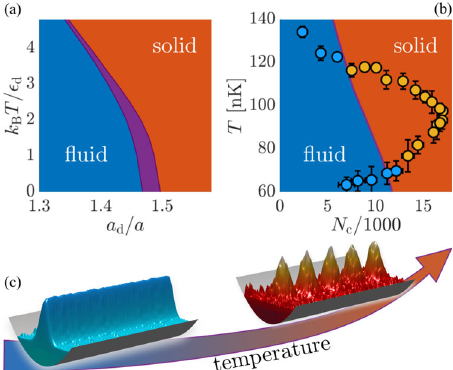
Fig. 1 | Temperature-driven formation of supersolidity. Heating a dipolar quantum fl uid can lead to the emergence of a supersolid phase of matter, as illu- strated schematically in c . a This is demonstrated in the thermodynamic phase diagram for an in fi nitely elongated Bose – Einstein condensate in a radial harmonic trap without axial con fi nement. In between the super fl uid (blue) and supersolid (red) region, both phases coexist (purple region) as characteristic for a fi rst-order phase transition. The calculations were performed for a fi xed chemical potential ϵ _ 2 = ðð 12 π Þ 2 ma 2 Þ parametrizes the characteristic energy scale of μ / ϵ d =1, where d = d the dipole-dipole interactions. Measurements of supersolid formation during the cooling of a gas ofdysprosium atoms 8 indicate the temperature-driven emergence of supersolidity. The color of the dots in b indicates the measured density mod- ulation M whereby orange dots correspond to a large contrast M >0 : 2 and blue corresponds to an unmodulated condensate with M <0 : 2. Our observations agree well with the theoretically predicted transition (purple line) and show that super- solidityindeedariseswithincreasingtemperaturewhilekeepingthenumber, N c ,of condensed atoms as well as the interaction strengths ( a d / a =1.46 and a =4.7nm) fi xed. The error bars in b indicate the statistical uncertainty (one standard devia- tion) ofthe measured number of condensed atoms (horizontal error bars) and the temperature (vertical error